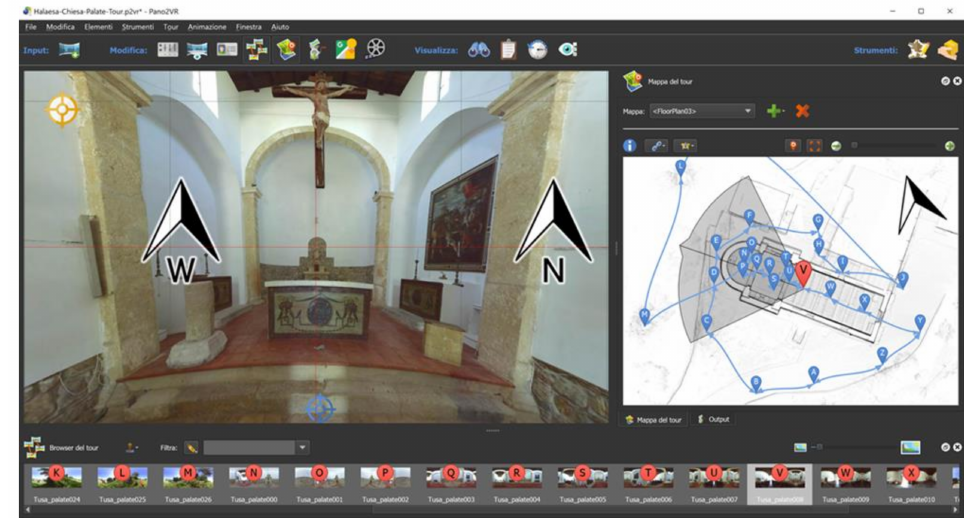
Figure 14. Observation point of virtual tour project; screen from